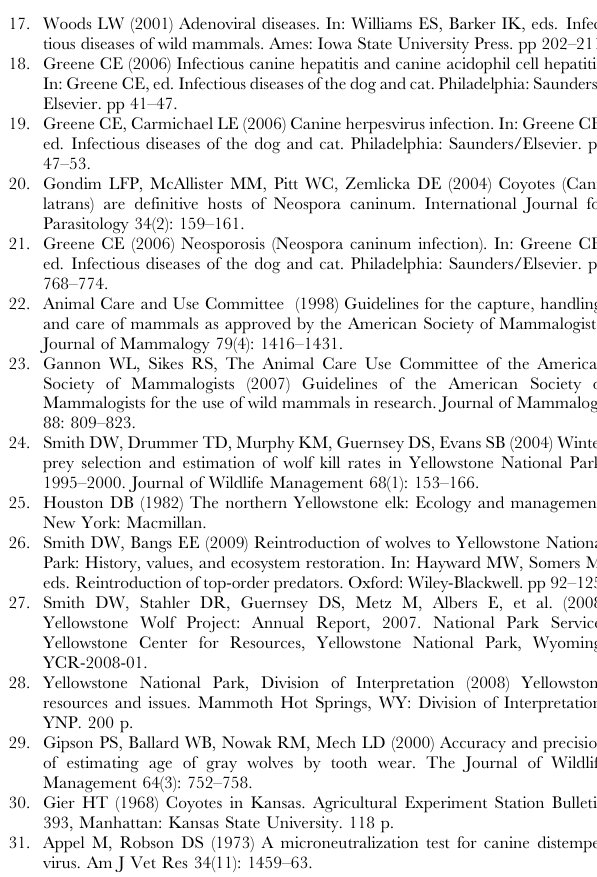
Figure S1 Mean wolf antibody titers to canine distemper virus in Yellowstone National Park, 1997–2007. Mean log 2 (antibody titers) are displayed with corresponding 95% confidence intervals for Northern Range (NR) and Interior pups (A) and adults